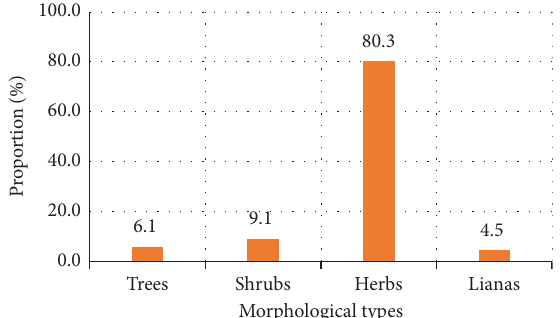
Figure 13: Proportion of morphological